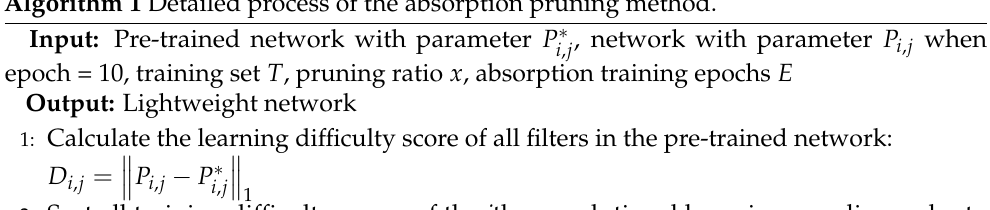
Algorithm 1 Detailed process of the absorption pruning